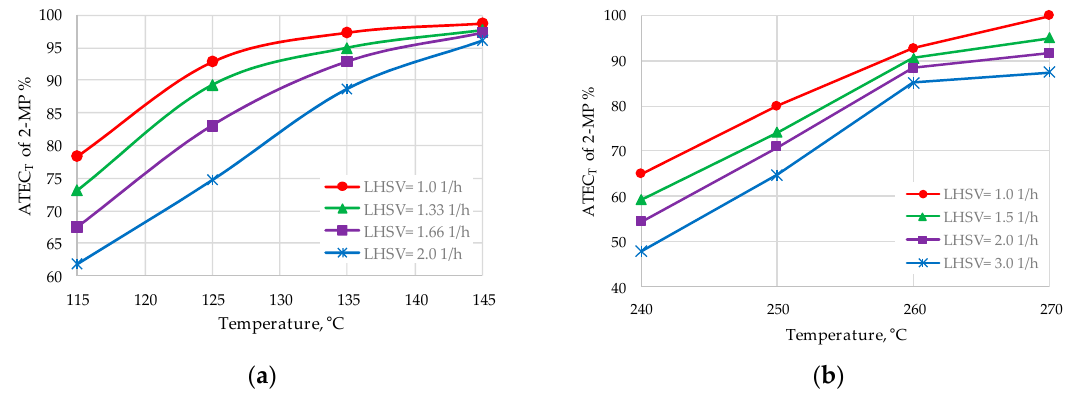
Figure 8. ATEC values of 2-MP ( a ) (catalyst: Pt/Al 2 O 3 /Cl, feedstock: “A”); and 2-MP ( b ) (catalyst: Pt/H-Mordenite/Al 2 O 3 , feedstock: “B”) as a function of temperature and LHSV.